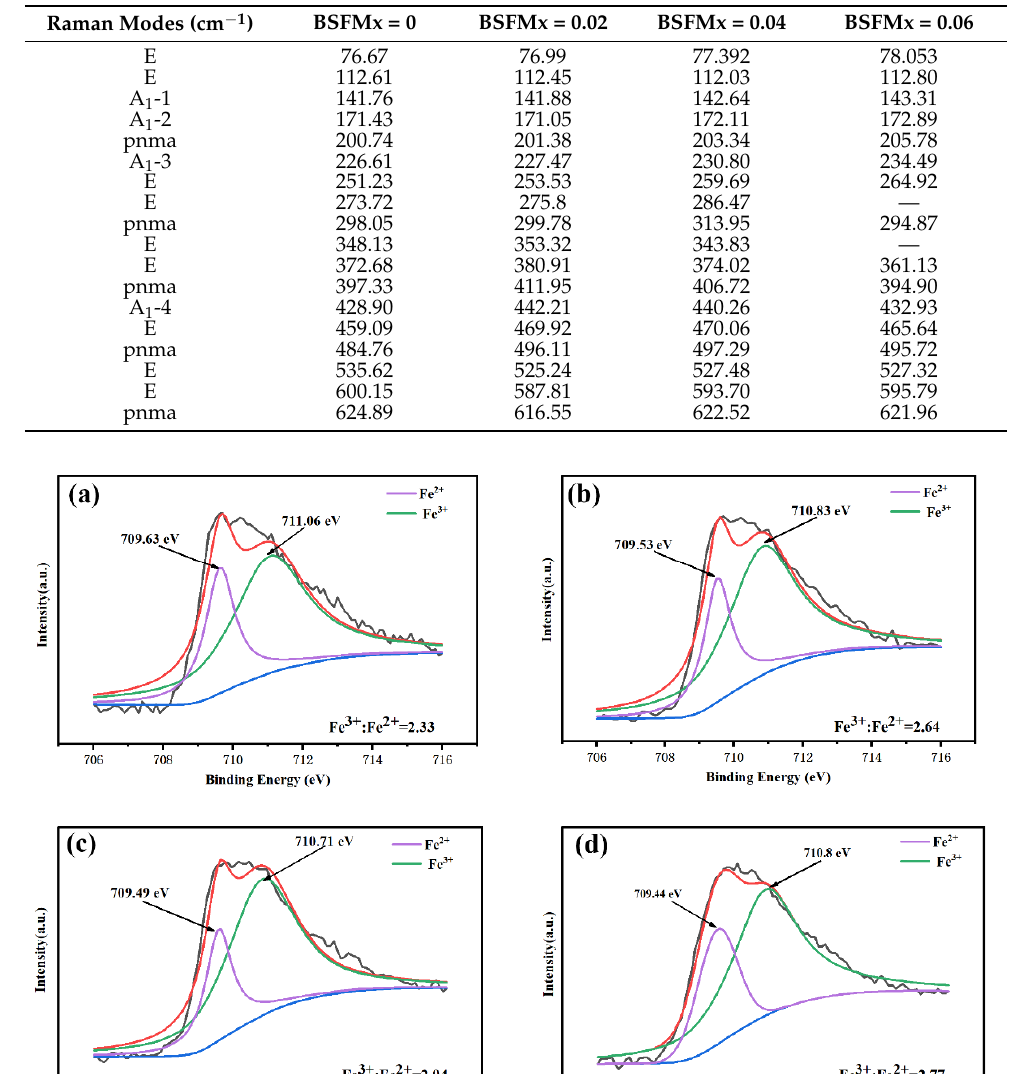
Table 2. The Raman modes of the BSFM films with different Sm content.